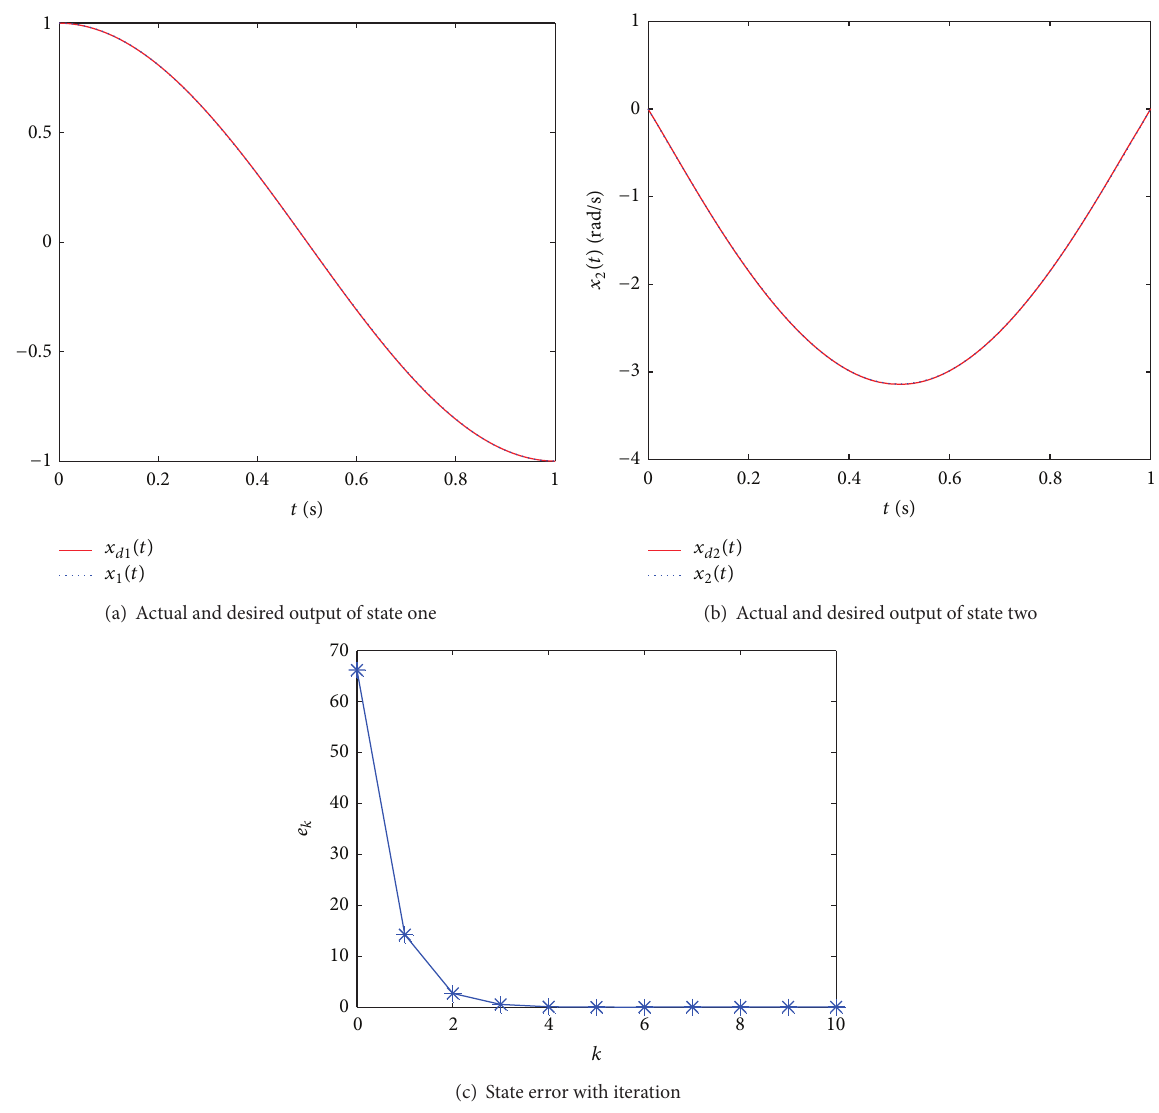
Figure 1: Single model ILC when 𝑑 𝑘 (𝑡) =